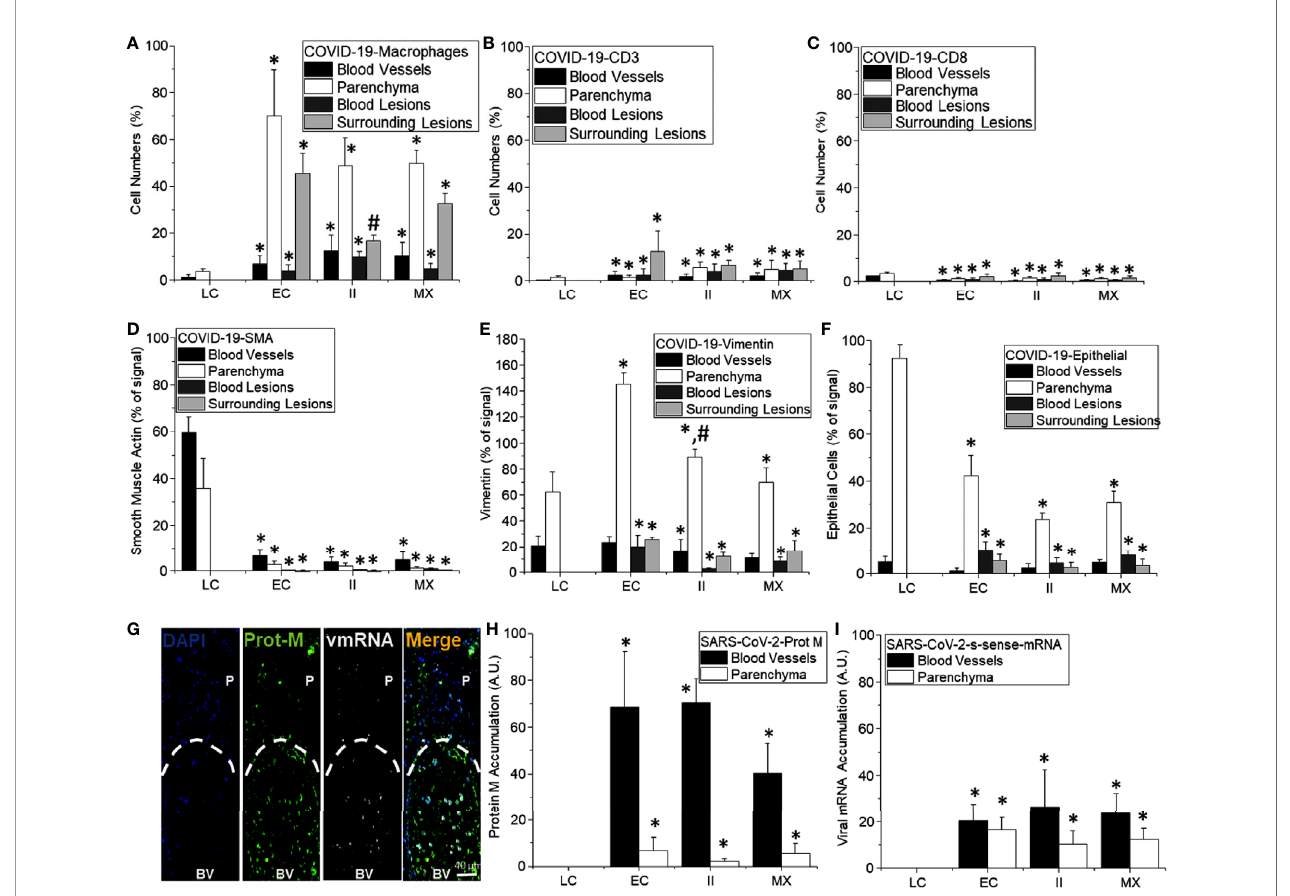
FIGURE 11 | Quanti fi cation of cell structure and lung damage in lethal cases of COVID-19. (A – F) Correspond to the quanti fi cation of different cell types in different compartments of the lung, including blood vessels (black bars), parenchyma (white bars), blood lesions (dark lead-colored bars), and cells surrounding hemorrhagic lesions (lead-colored bars). (A) In control conditions (LC for lung carcinoma), minimal numbers of macrophages were detected (mostly resident macrophages). In contrast, in the COVID-19 enhanced coagulation phenotype (EC), a strong in fi ltration of monocyte/macrophages into the lung parenchyma and around hemorrhagic lesions. Moreover, in the COVID-19 immune in fi ltration phenotype that lacks hemorrhagic lesions, most macrophages were in the lung parenchyma. (*p ≤ 0.005 compared to lung carcinoma conditions and # p ≤ 0.0001 compared to enhanced coagulation condition, n = 4 different individuals with fi ve sections each). (B) Quanti fi cation of CD3 cells in different lung compartments as described above. A small and localized CD3 response was found (*p ≤ 0.001 compared to lung carcinoma conditions, n = 13 different individuals with fi ve sections each). (C) Quanti fi cation of CD8 cells as compared to uninfected samples obtained from individuals with suspected lung carcinoma. Overall, COVID-19 induced a poor CD8 response in the lung in these lethal cases (*p ≤ 0.005 as compared to lung carcinoma conditions, n = 13 different individuals with fi ve sections each). (D) Quanti fi cation of smooth muscle cells indicates a strong negative effect of COVID-19 in these cells. Overall, SMA or SMC were eliminated by the infection independent of the area analyzed and the damage type induced by COVID-19 infection (*p ≤ 0.001 compared to lung carcinoma conditions, n = 13 different individuals with fi ve sections each). (E) Quanti fi cation of vimentin-positive cells in COVID-19 lethal cases. Overall, there was a signi fi cant and strong increase in Vimentin positive cells, especially in the lung parenchyma (*p ≤ 0.0001 compared to lung carcinoma conditions, n = 13 different individuals with fi ve sections each). (F) Quanti fi cation of epithelial cells in COVID-19 cases, overall, there is a signi fi cant decrease in EpCam staining and numbers of positive cells; however, a critical point is the de-attachment of the remaining epithelial cells from the alveolar wall (*p ≤ 0.0005 compared to lung carcinoma conditions, n = 13 different individuals with 5 section each). (G) representative image of the distribution of the viral protein M and the viral mRNA (sense). It is possible to observe the accumulation of these viral components in the circulation and not in the parenchyma ( H, I , for viral protein M and viral mRNA, respectively. (*p ≤ 1x10 -7 compared to lung carcinoma conditions, n = 13 different individuals with 5 sections